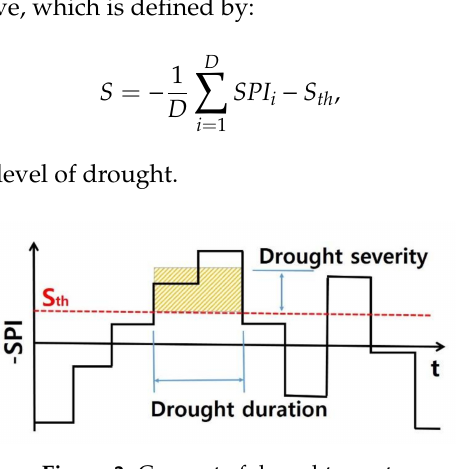
Figure 3. Concept of drought